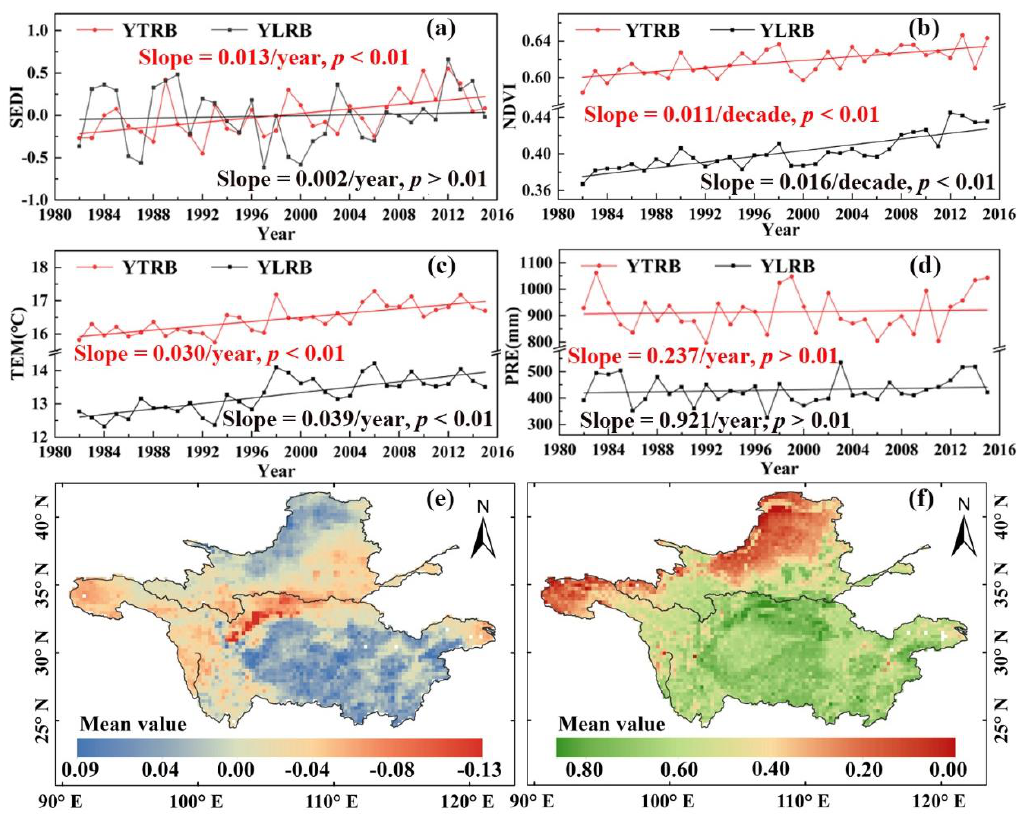
Figure 2. Variation of the mean SEDI ( a ), mean NDVI ( b ), mean TEM ( c ), and accumulated PRE ( d ) in the growing season from 1982 to 2015; spatial distribution of the mean SEDI ( e ) and mean NDVI ( f ). The drought and vegetation coverage in the YLRB and YTRB had clear spatial heterogeneity ( Figure 2 e, f). The low-SEDI areas (values of less than 0) in the YLRB were mainly distributed in the eastern region, while in the YTRB, the low-SEDI areas were mainly centered in the western region. The NDVI in most areas of the YLRB was lower than 0.5, and was particularly low in the Loess Plateau (<0.2). The vegetation coverage in the southeastern region was slightly higher than that in the middle region of the YLRB. The vegetation coverage in the YTRB was good, with an NDVI greater than 0.5 in more than 80% of the region. In the central and eastern basins, the vegetation coverage was better than that in other regions. Low-value areas (<0.2) were mainly centered in the upper reaches and were covered by grassland and alpine meadows, as well as glaciers and permanent snow. No significant trend was observed in SEDI in most areas of the YLRB, and the slope remained near 0, thereby maintaining a generally stable state ( Figure 3 ). However, in the YTRB, more than 40% of the areas had a significant trend of wetness, which was mainly centered in the eastern source region and the central and eastern regions. In addition, 9.44% of the area, which was mainly distributed in the northern basin, showed a significant drying tendency ( Table 2 ). According to the annual change trend of vegetation coverage during the growing season, 69.91% of the YLRB showed a significant greening trend and 54.22% of the YTRB area was turning green; these areas were mainly concentrated in the central and eastern regions of both basins.